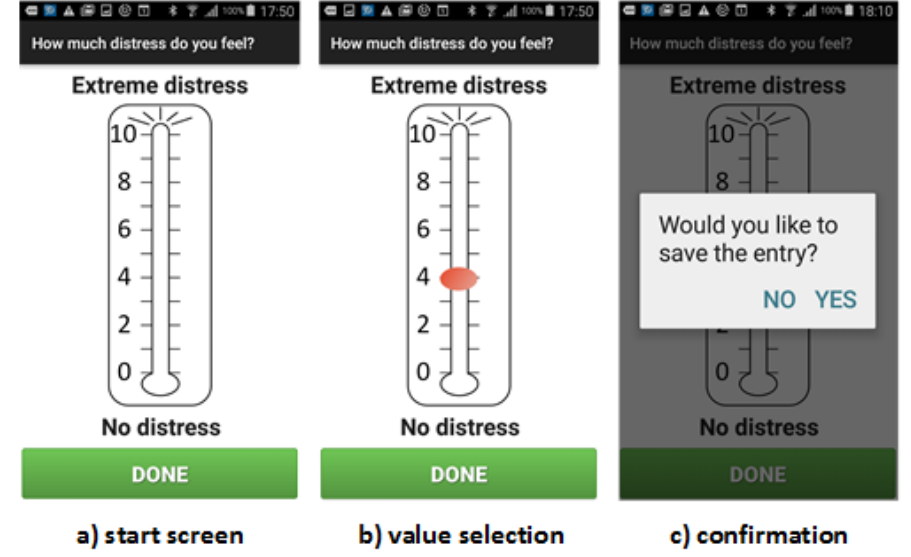
Figure 2. Digital Version of the NCCN Distress Thermometer: a) graphical design is based on validated paper version of the NCCN Distress Thermometer [17], b) value selection by tapping and sliding, c) confirmation